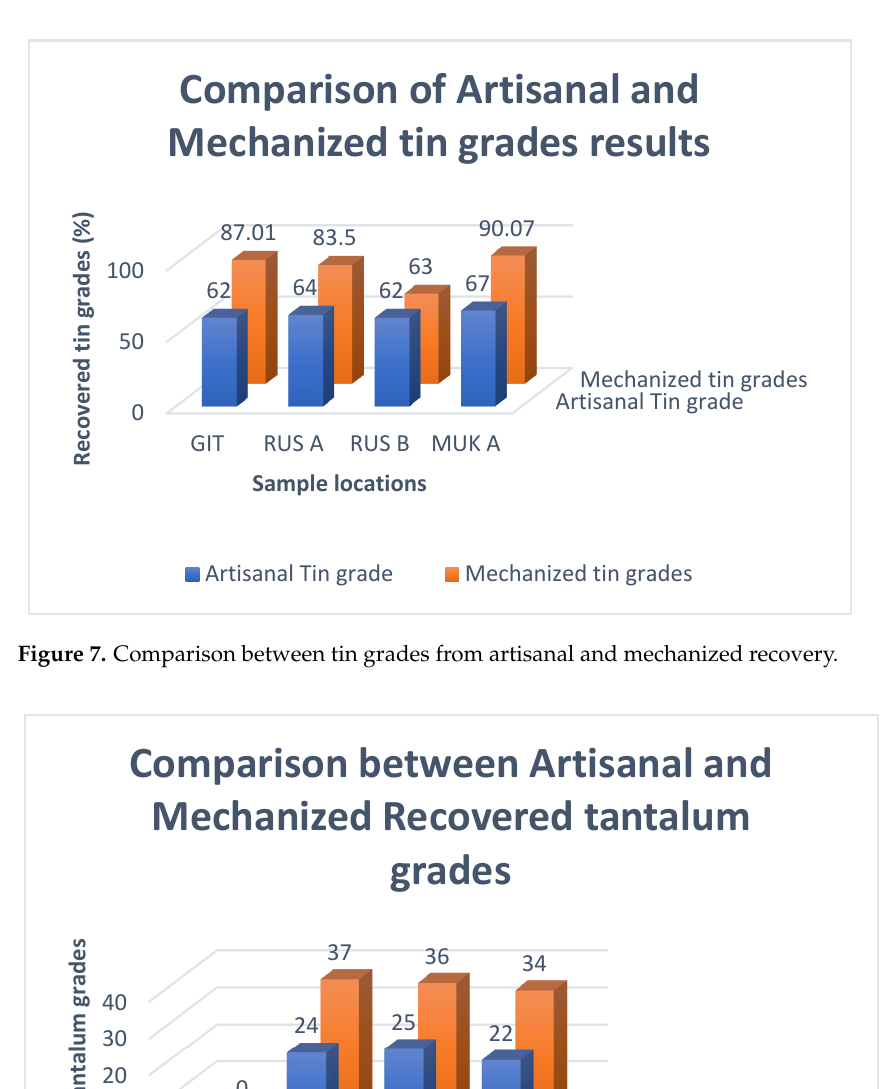
Table 1. Artisanal processing results.